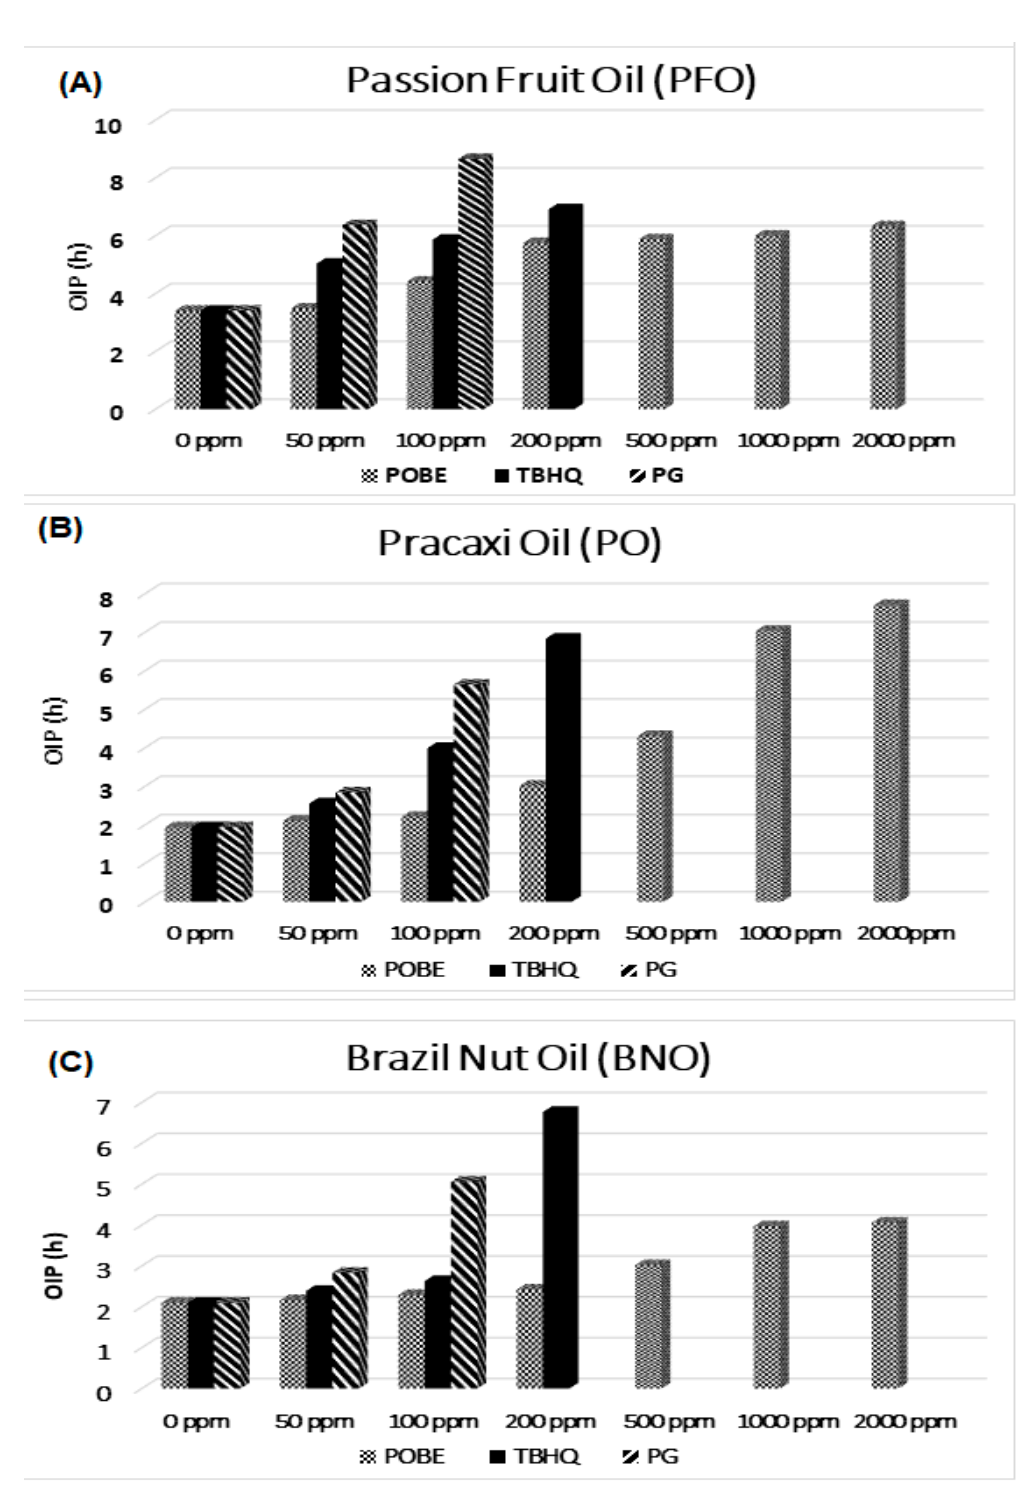
Figure 3. Rancimat induction period vs. antioxidant concentration measured at 110 °C. ( A ) Passion Fruit Oil (PFO); ( B ) Pracaxi Oil (PO); ( C ) Brazil Nut Oil (BNO).